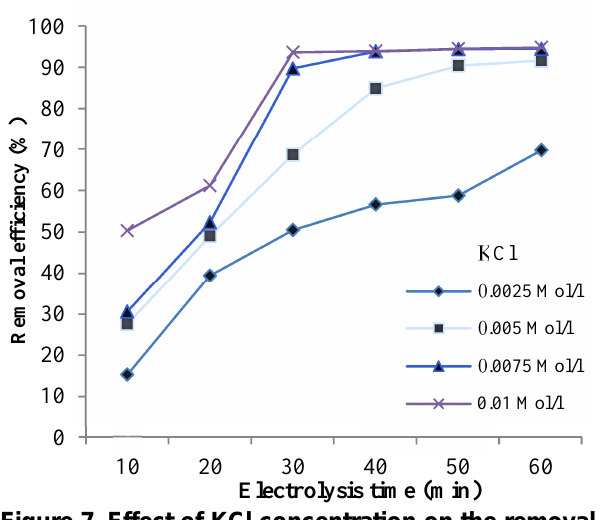
Figure 7. Effect of KCl concentration on the removal efficiency of Reactive Green 19 (RG-19) dye (Voltage = 50 v, C = 50 mg/l, d = 1 cm, pH =11, 0 T = 22 ± 2 º C)